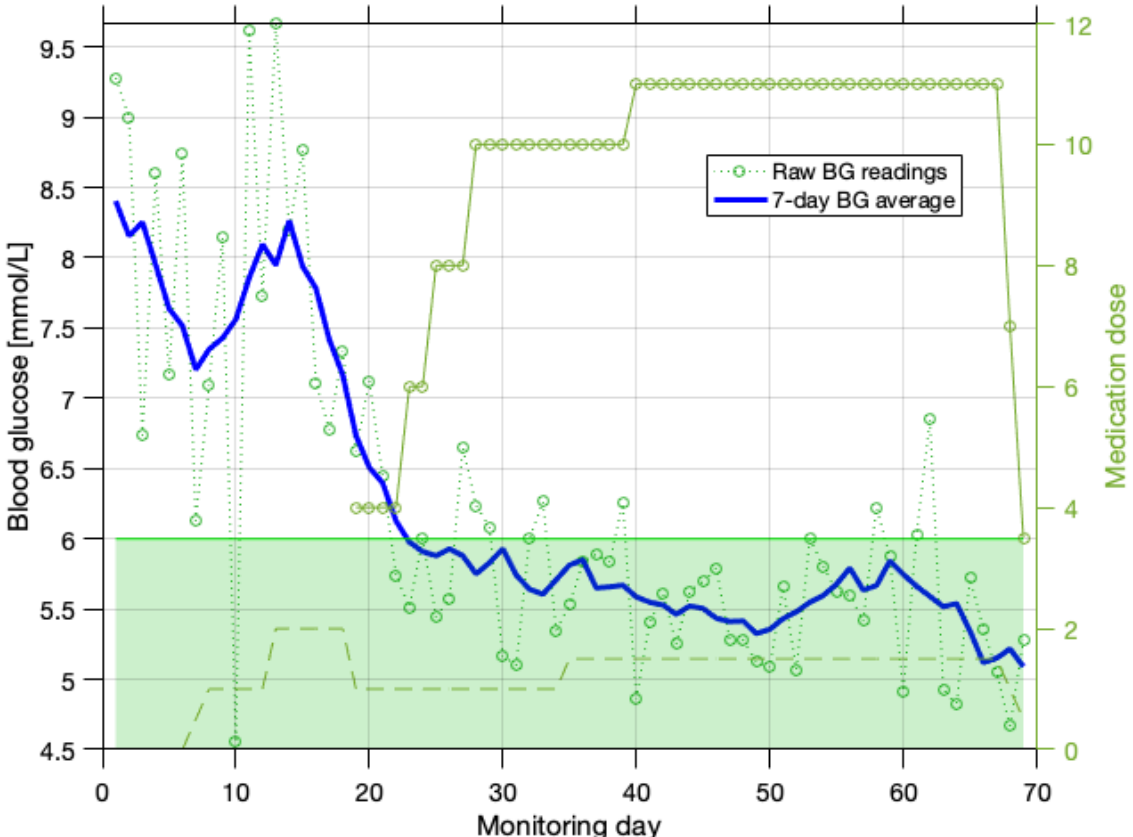
Figure 1. Patient data sample illustrating blood glucose readings, 7-day average blood glucose (BG), medication information, and target range (green shading). Both the dashed and solid circled lines represent medications. In this instance, the use of appropriate medication and dosage allows BG to reach the target range. BG: blood